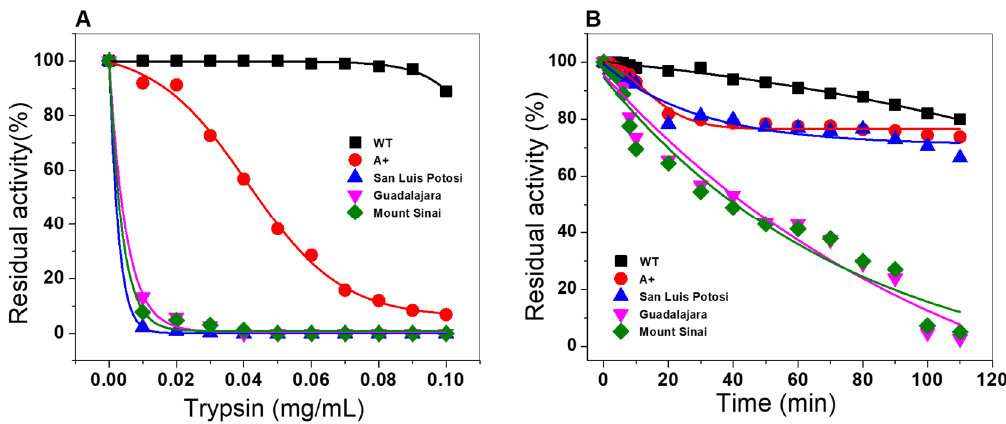
Figure 11. Evaluation of stability of G6PD proteins in trypsin digestion. Trypsin digestion of WT G6PD enzyme and single natural variants G6PD A + , G6PD San Luis Potosi, and G6PD Guadalajara and double mutant G6PD Mount Sinai in the ( A ) absence and ( B ) presence of NADP + as stabilizing agent and different concentrations of trypsin.